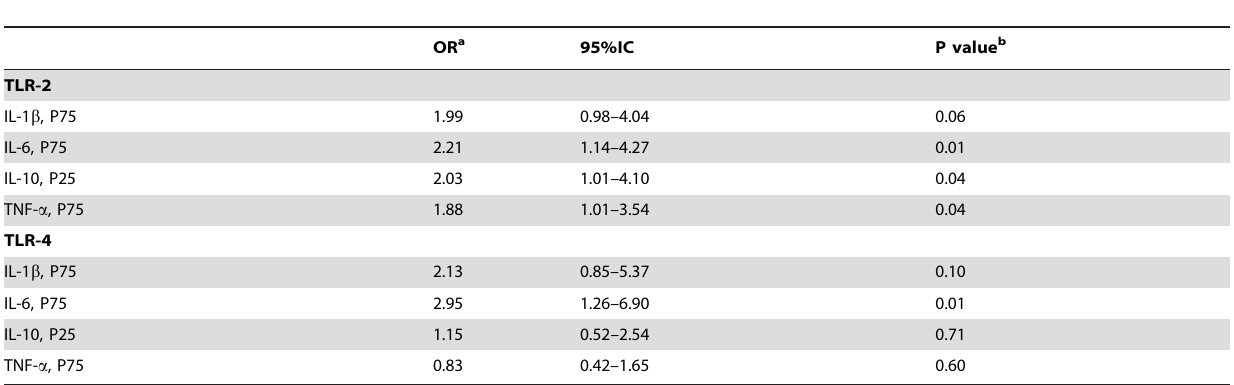
Table 5. Association between the expression of Toll-like receptors (TLR-2/4) and the production of cytokines (in quartiles) in 311 postmenopausal